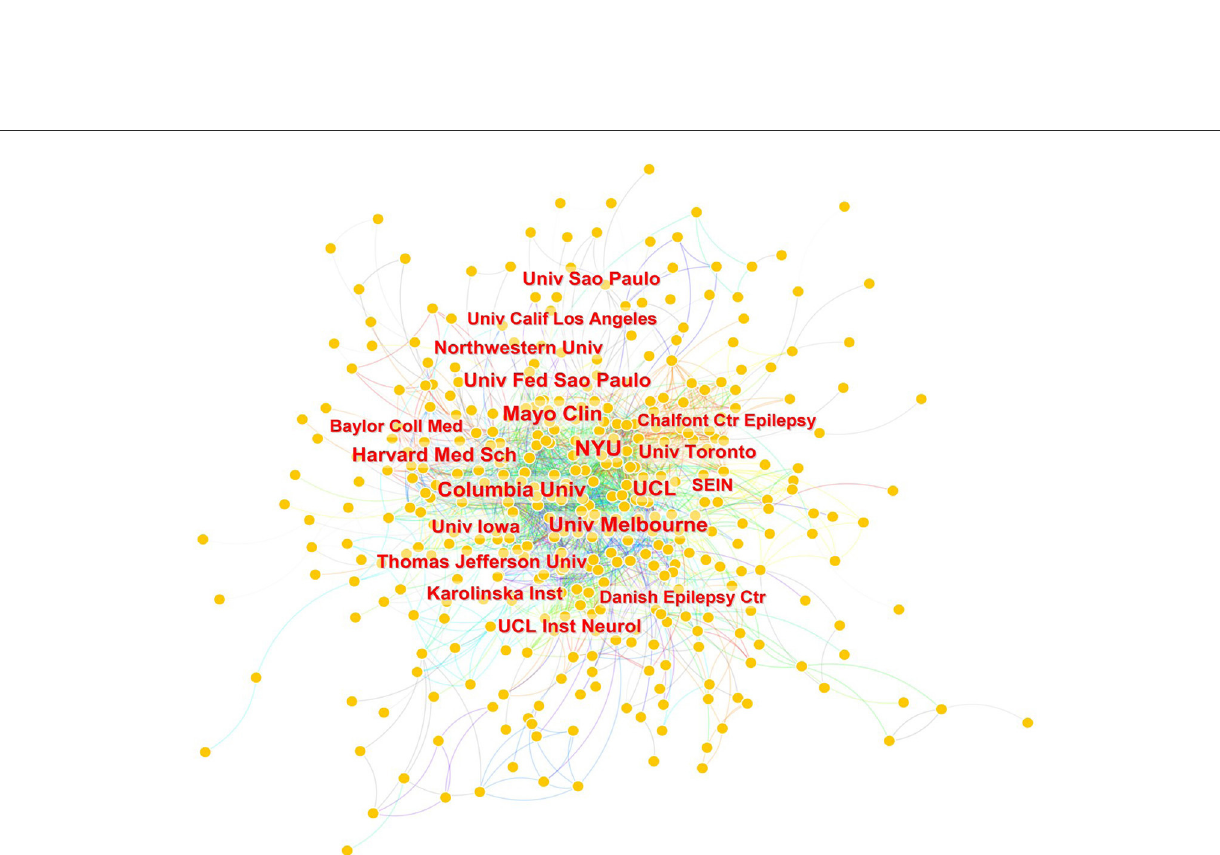
FIGURE4 Network map of institutions engaged in SUDEP